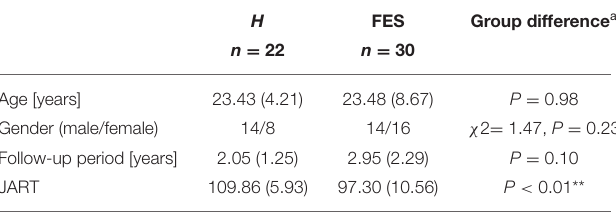
TABLE 1 | Demographic and clinical data for groups H and FES. TABLE 2 | Demographic and clinical data for groups R and